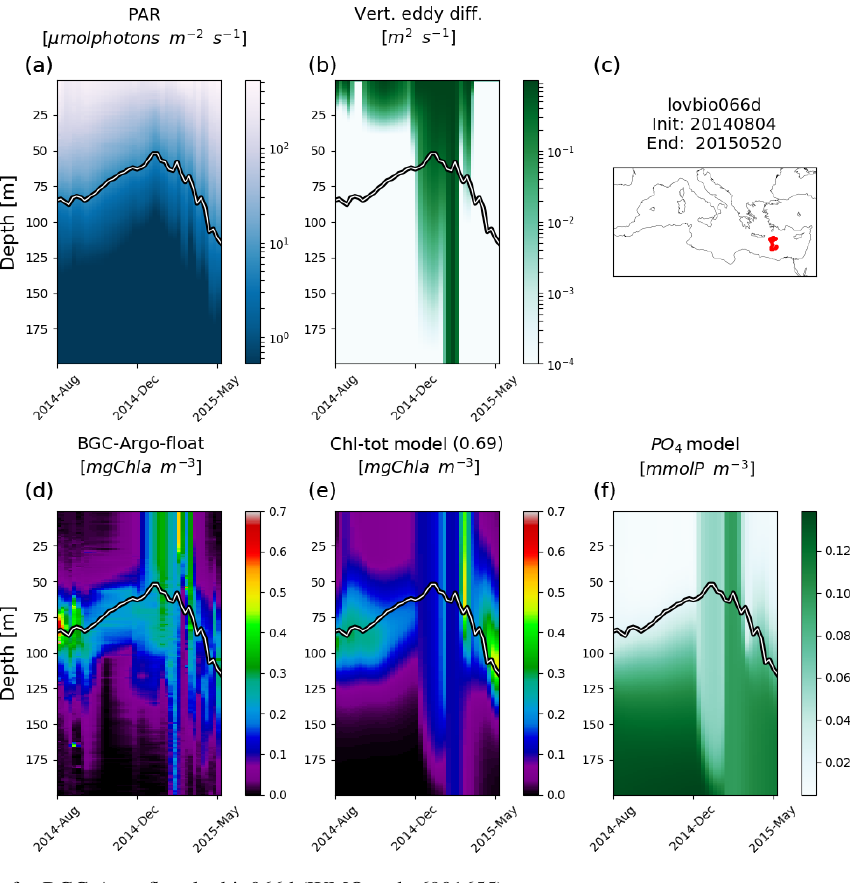
Figure 6. As Fig. 3 but for BGC-Argo float lovbio066d (WMO code 6901655).